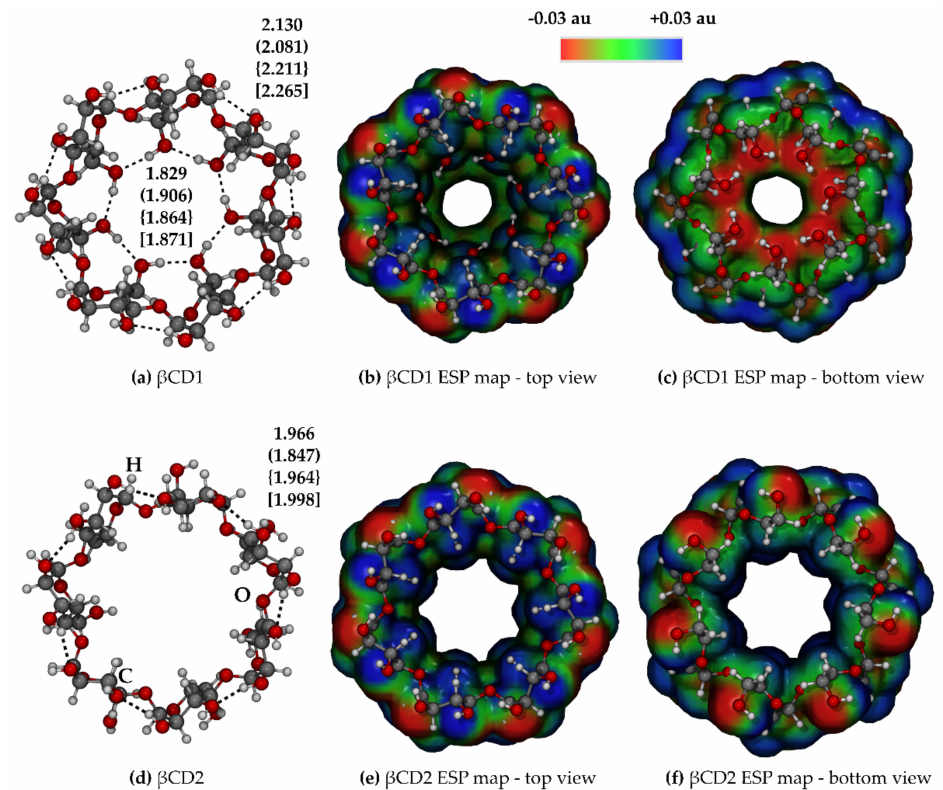
Figure 6. ( a ) Optimized structure of β -cyclodextrin. Bond length notation: GFN2, (GFNFF), {B3LYP}, [PBEh-3c]. ( b , c ) β -cyclodextrin structure superimposed on the ElectroStatic Potential (ESP) maps plotted on the electron density (ISO electron density value = 10 − 3 au). Bond distances are in Å. Atom colors: H white, C grey, N blue, O